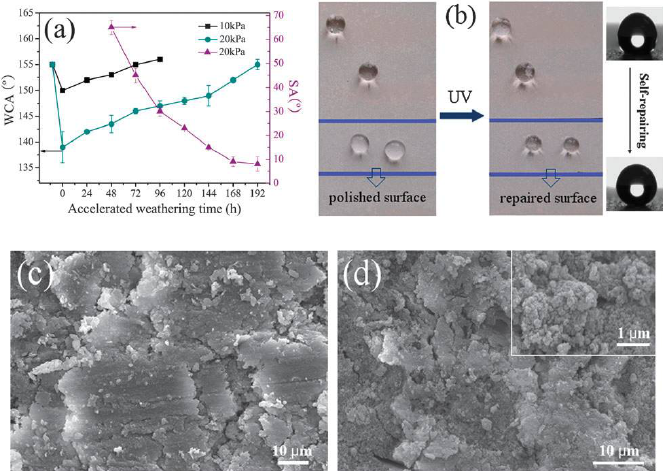
Figure 7. ( a ) The recovery of WCA and SA of the polished FMS/TiO 2 -based superhydrophobic surfaces in an accelerated weathering tester; ( b ) photographs of water droplets and contact angles (139.11°–155.31°) on the polished surface and the repaired superhydrophobic surface (192 h exposure in the accelerated weathering tester); ( c , d ) SEM images of the polished surface after 10 cycles of abrasion under a 20 kPa pressure, and the repaired surface (192 h exposure in the accelerated weathering tester). (Composition: PMSF/PS/FMS/P25 = 17.1/40.9/36.0/6.0 wt/wt). Reprinted from [83] with permission; Copyright Royal Society of Chemistry 2014.